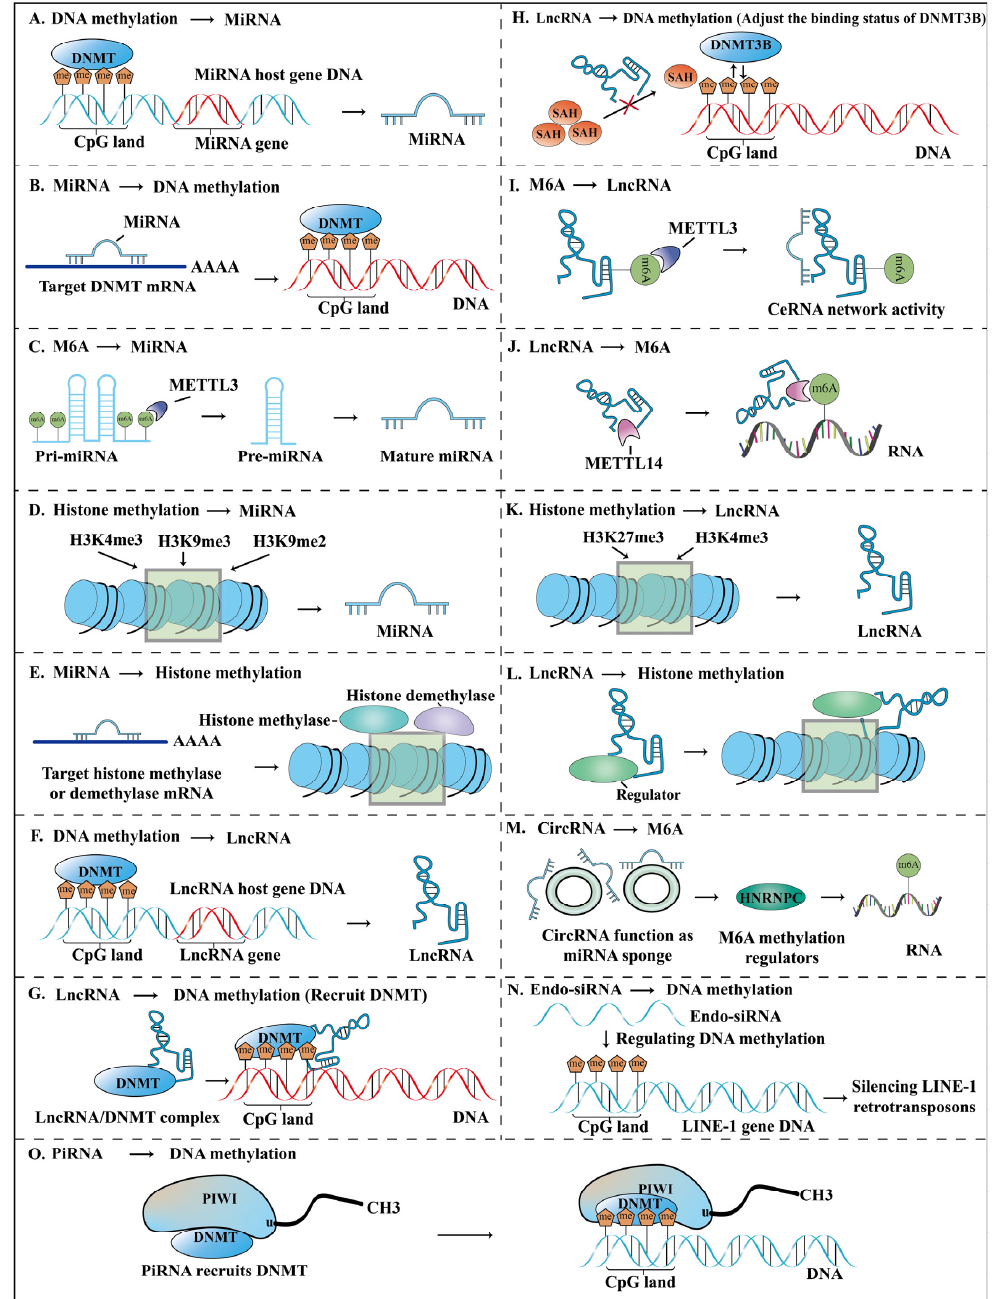
Figure 2. The summary of the interaction between ncRNAs and methylation modifications in BC. ( A ). Regulation of miRNA by DNA methylation. ( B ). Regulation of DNA methylation by miRNA. ( C ). Crosstalk between m6A and miRNA. ( D ). Regulation of miRNA by histone methylation. ( E ). Regulation of histone methylation by miRNA. ( F ). Regulation of lncRNA by DNA methylation. ( G ). Regulation of DNA methylation by lncRNA (lncRNA recruits DNMTs). ( H ). Regulation of DNA methylation by lncRNA (lncRNA regulates the binding status of DNMTs). ( I ). m6A modification on lncRNA. ( J ). lncRNA regulates m6A RNA methylation. ( K ). Regulation of lncRNA by histone methylation. ( L ). Regulation of histone methylation by lncRNA. ( M ). CircRNA indirectly regulates m6A modification. ( N ). Regulation of DNA methylation by endo-siRNA. ( O ). Regulation of DNA methylation by piRNA.